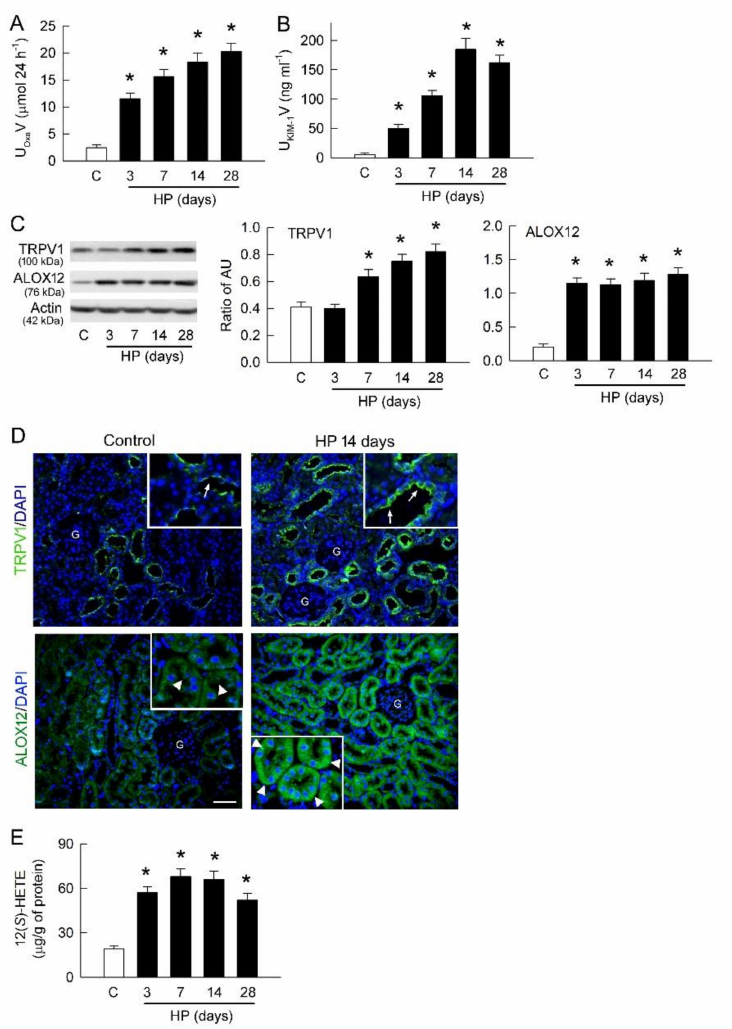
Figure 5. Effect of hyperoxaluria on renal TRPV1, ALOX12, and 12( S )-HETE expression. ( A ) Urine samples were collected daily from metabolic cage study to measure excreted oxalate after hyperox- aluric (HP) induction. Urine in control (C) rats was collected only on day 28. Note that hyperoxaluria increases in a time-dependent manner in HP rats. ( B ) Urinary KIM-1 level, as a marker for tubular damage, demonstrates an increase in HP rats at all induction times. ( C ) Representative blots are shown for TRPV1 and ALOX12 expression using 10 µ g of total protein in each lane. Right bar graph shows densitometrically quantified results by ratio of TRPV1 or ALOX12 to actin. AU, abritary unit of band density. ( D ) Representative pictures show tissue localization of TRPV1 (upper two pictures) and ALOX12 (lower two pictures) in renal cortex of control and 14-day HP kidneys at 200 × magnification. Cell nuclei are counterstained with DAPI (blue). G, glomerulus. The local tissue of the renal cortex was magnified at 400 × (insets) and demonstrated that TRPV1 and ALOX12 (green) are present at apical membrane (indicated by arrows) and cytosol (indicated by arrow heads) of renal tubules, respectively, in control and HP (14 days) kidneys. These expressions are increased in HP kidney. ( E ) Tissue content of 12( S )-HETE in renal cortex; n = 6 for each group and time point for all bar graphs. * p < 0.05, HP vs. control by unpaired t